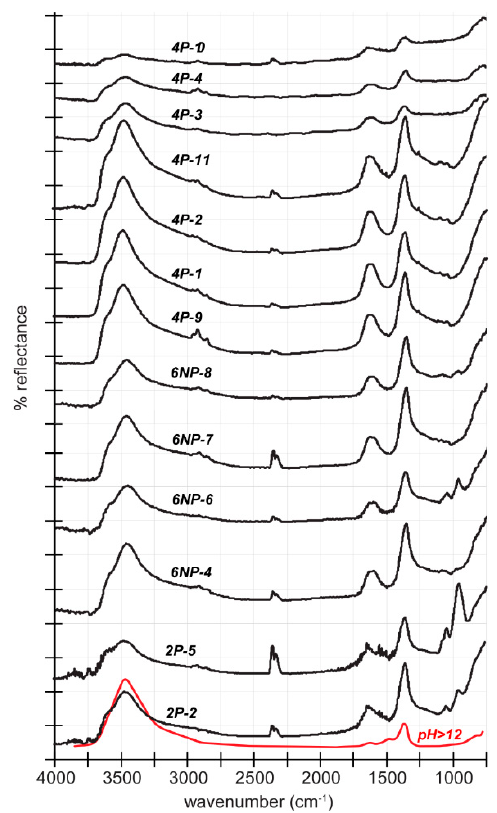
Figure 5. FTIR spectra for stichtite nodules in samples 2P, 6NP, 4P. Red spectra is a synthetic stichtite precipitated from fluids with pH > 12 [40].